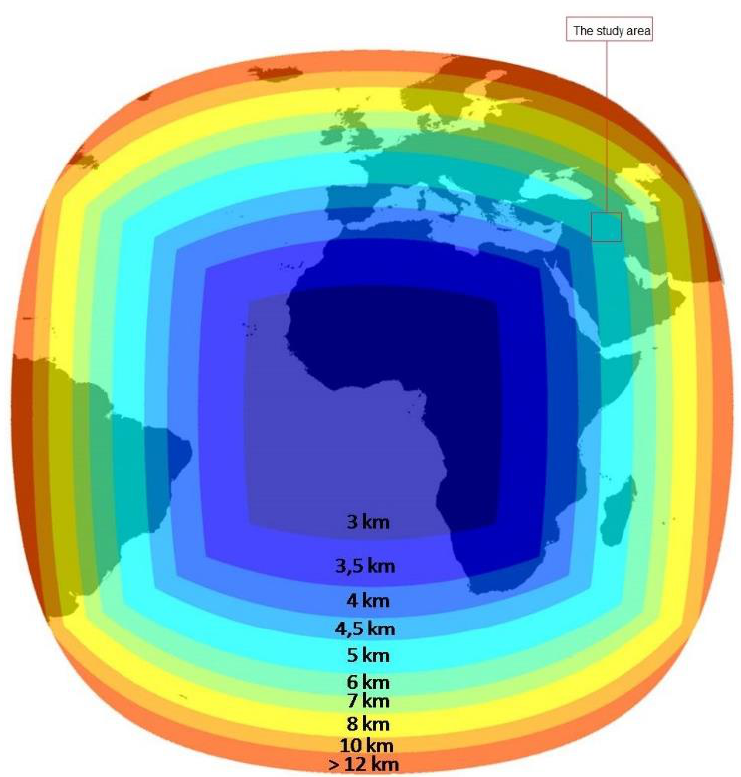
Figure 2. Spatial coverage of the SEVIRI instrument for MSG images [38].